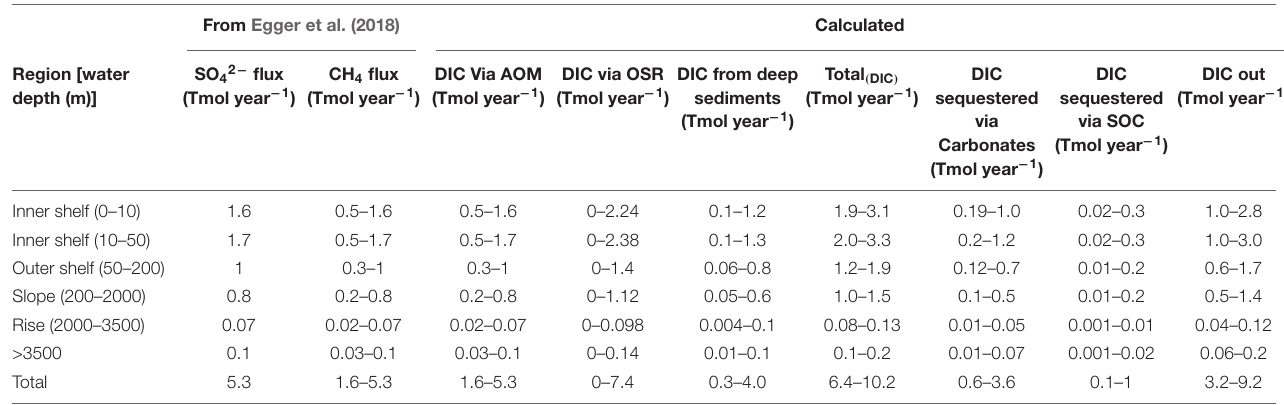
TABLE 4 | Range of DIC flux values based on variable ranges of DIC flux parameters in Table 1 details in the Supplementary Data . From Egger et al. (2018)